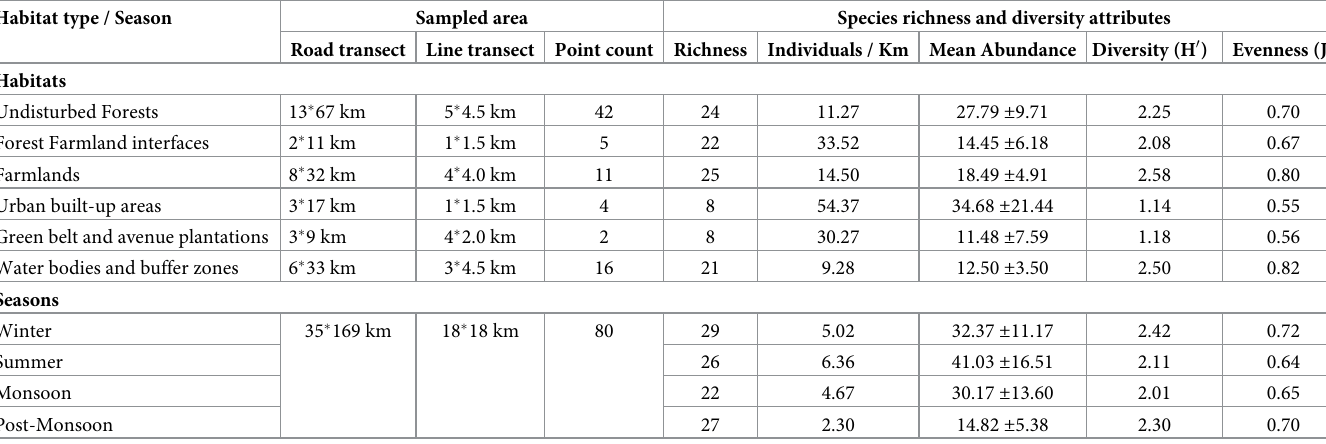
Table 1. Species richness and diversity of diurnal raptors in the study region as a function of habitats and seasons. Habitat type / Season Sampled area Species richness and diversity